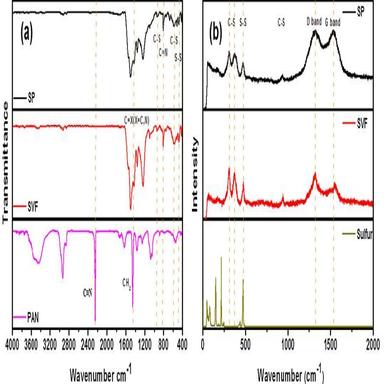
(a) FT-IR spectra of pure PAN, SVF and SP composites, and (b) Raman spectra of sulfur, SVF and SP composites.